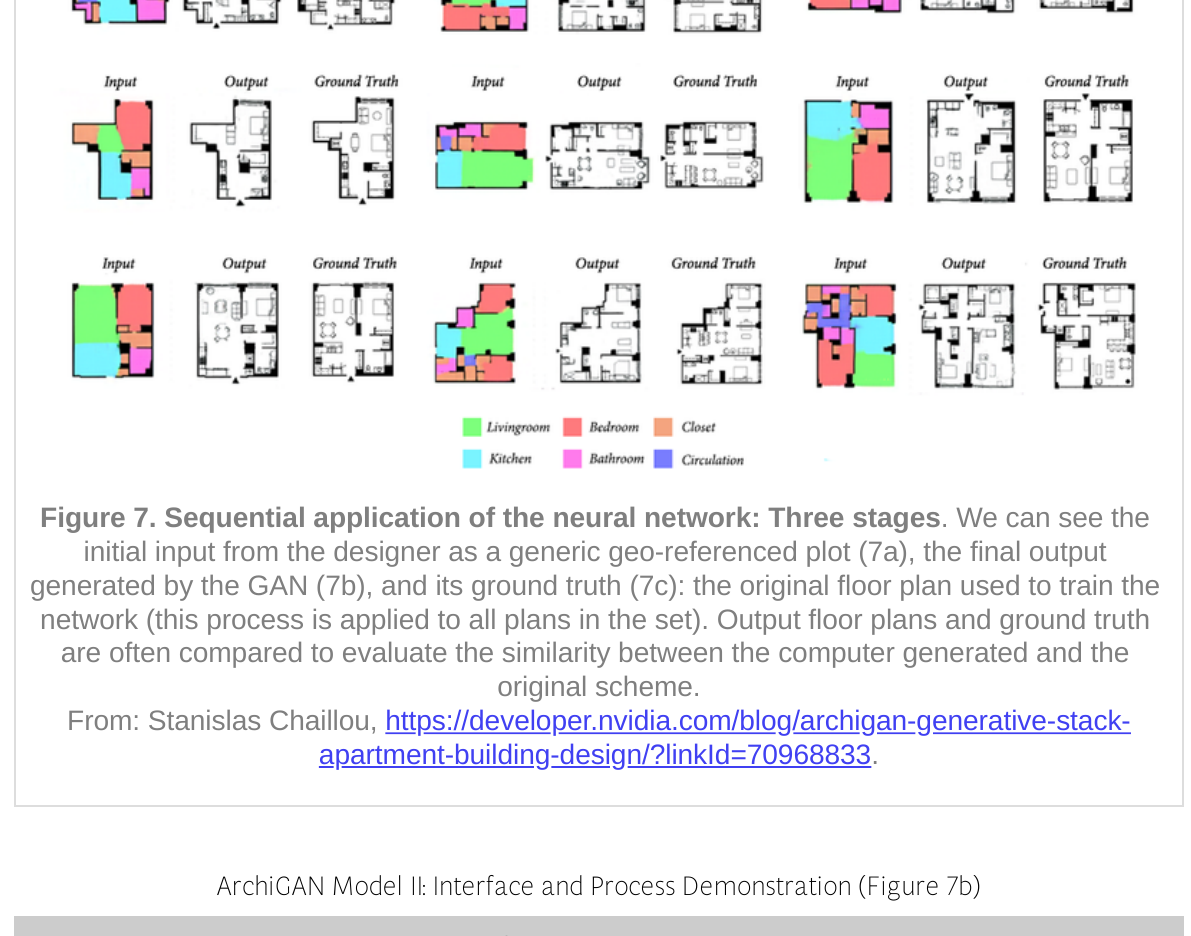
ArchiGAN Model II: Interface and Process Demonstration (Figure 7b) Visit the web version of this article to view interactive content.